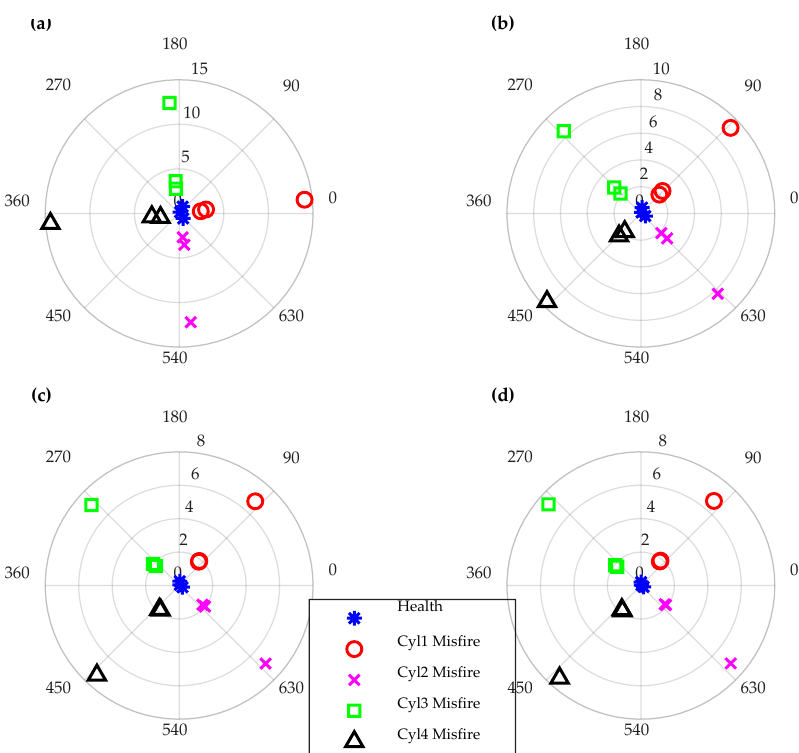
Figure 15. Polar plotting of fault indicators at 1300 rpm: ( a ) 0 Nm; ( b ) 105 Nm; ( c ) 210 Nm; ( d ) 315 Nm.